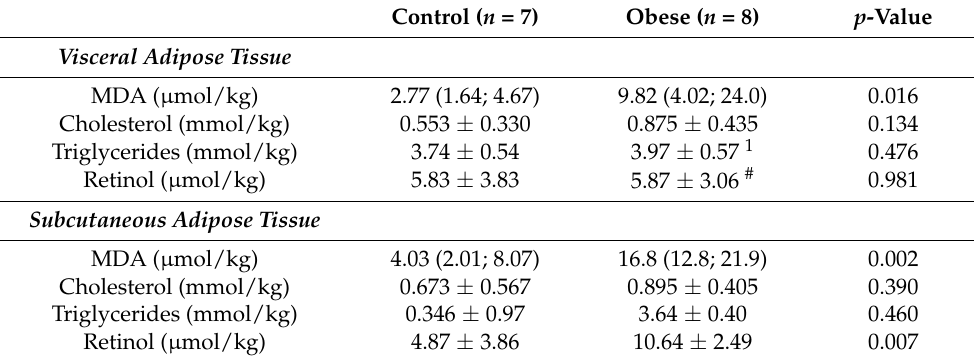
Table 5. Adipose tissue concentrations of